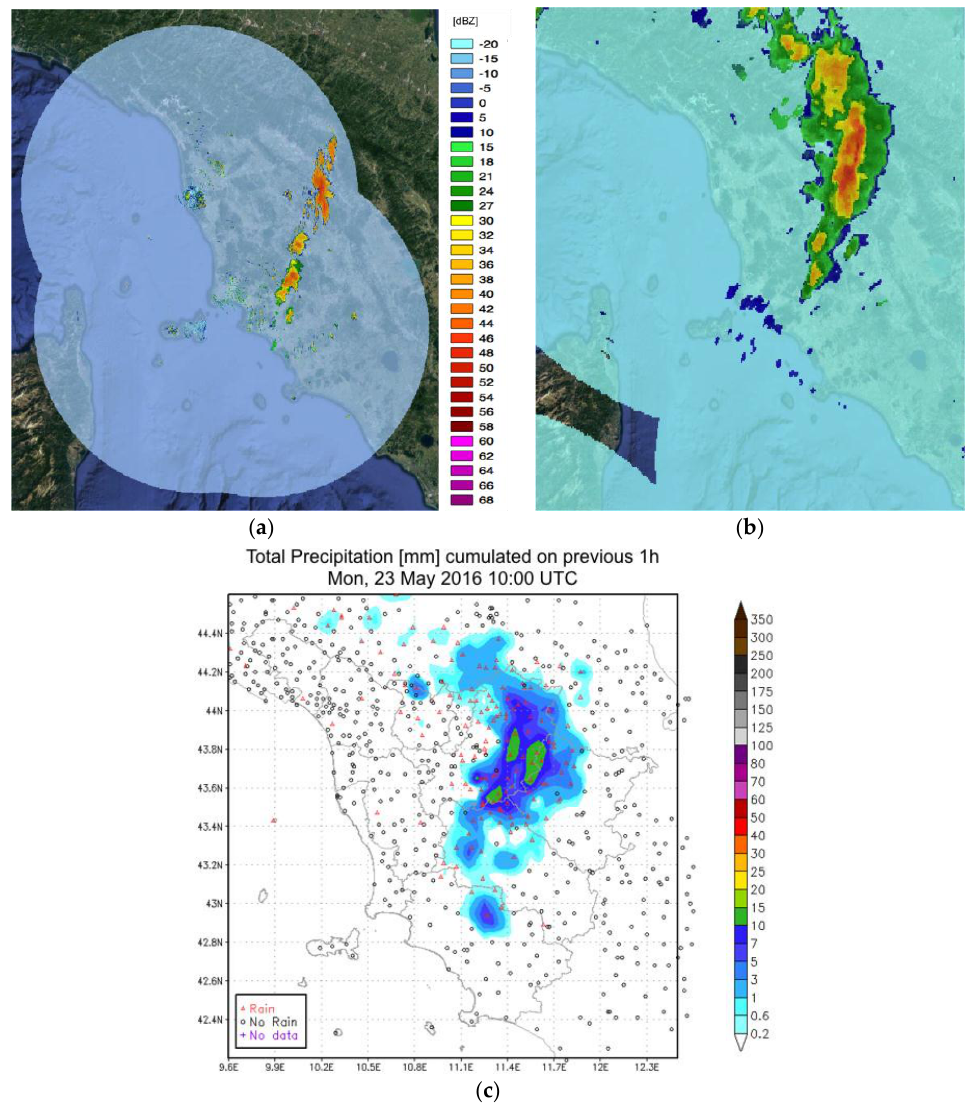
Figure 6. Case study of 23 May 2016, 09:00 UTC: ( a ) Mosaic of VMI (Vertical Maximum Indicator) reflectivity for the regional X-band radar network; ( b ) Mosaic of VMI reflectivity for the Italian National weather radar network; ( c ) 1-h (09:00–10:00 UTC) cumulated precipitation obtained from measurements of the regional rain gauge network.